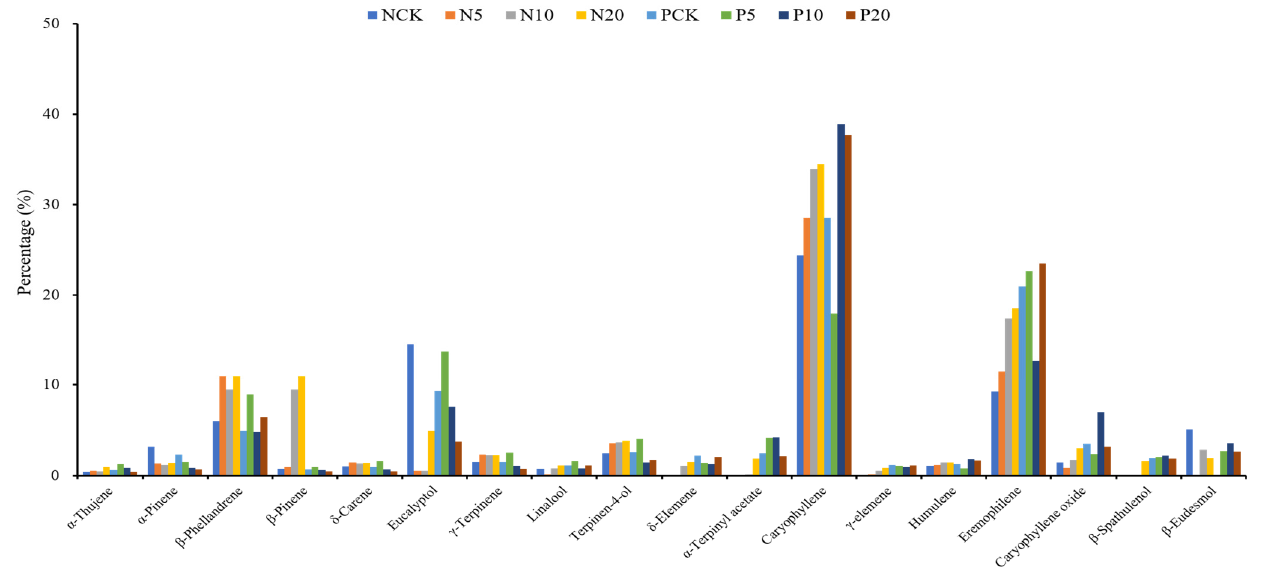
Figure 3. Effects of different fertilizer treatments on main essential oil components in shoots of V. negundo . Percentage values are the means of five analyses. V. negundo . Percentage values are the means of five